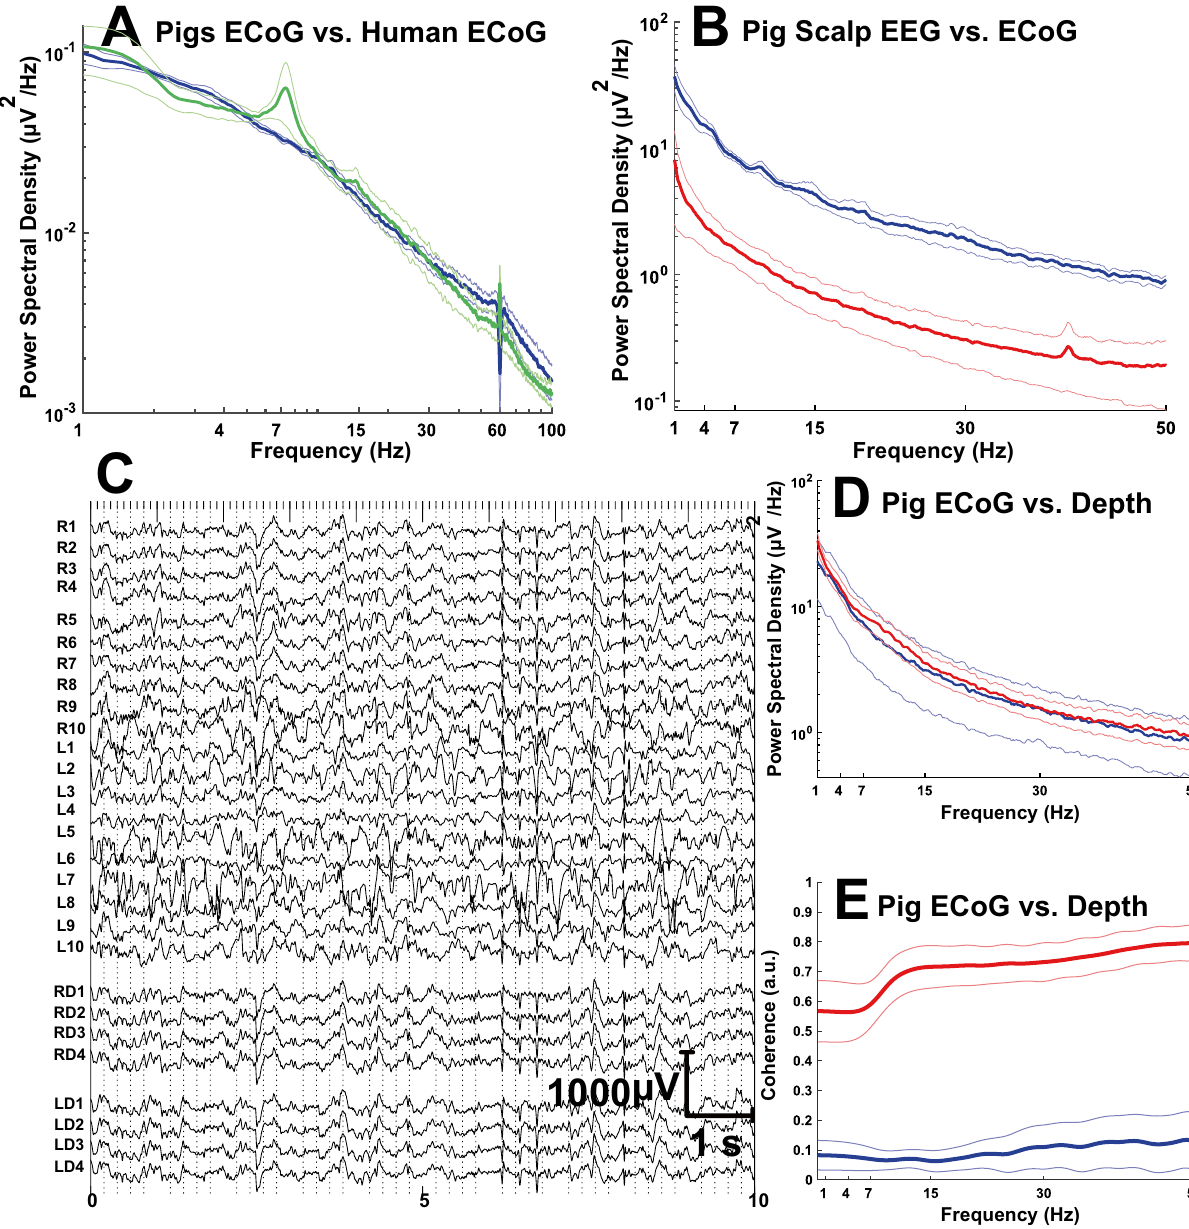
Figure 4. Human and pig neurophysiological network recordings. Pig electroencephalography, electrocorticography and depth electrode recordings, and human electrocorticography compared. ( A ) Human and pig ECoG comparison. Mean and standard error coherence of pig ECoG (blue line) and human ECoG (green line) recordings. ( B ) Mean (central line, intense color) and standard error (surrounding lines, less intense same color) power spectral density spectra of pig ECoG (blue line) and pig EEG (red line) recordings. ( C ) Unmodified pig ECoG (R1–R10, right and L1–L10, left ECoG electrodes) and depth electrode (RD1–RD4, right and LD1–LD4, left) tracings. ( D ) Pig mean and standard error power spectral density spectra of ECoG (blue) and depth (red) recordings, n = 6 pigs. ( E ) Pig mean and standard error coherence of ECoG (blue) and depth (red) recordings measured at electrodes R1-L1 and RD1-LD1 with n = 6 pigs. 1 indicates complete coherence, whereas 0 reflects absence of